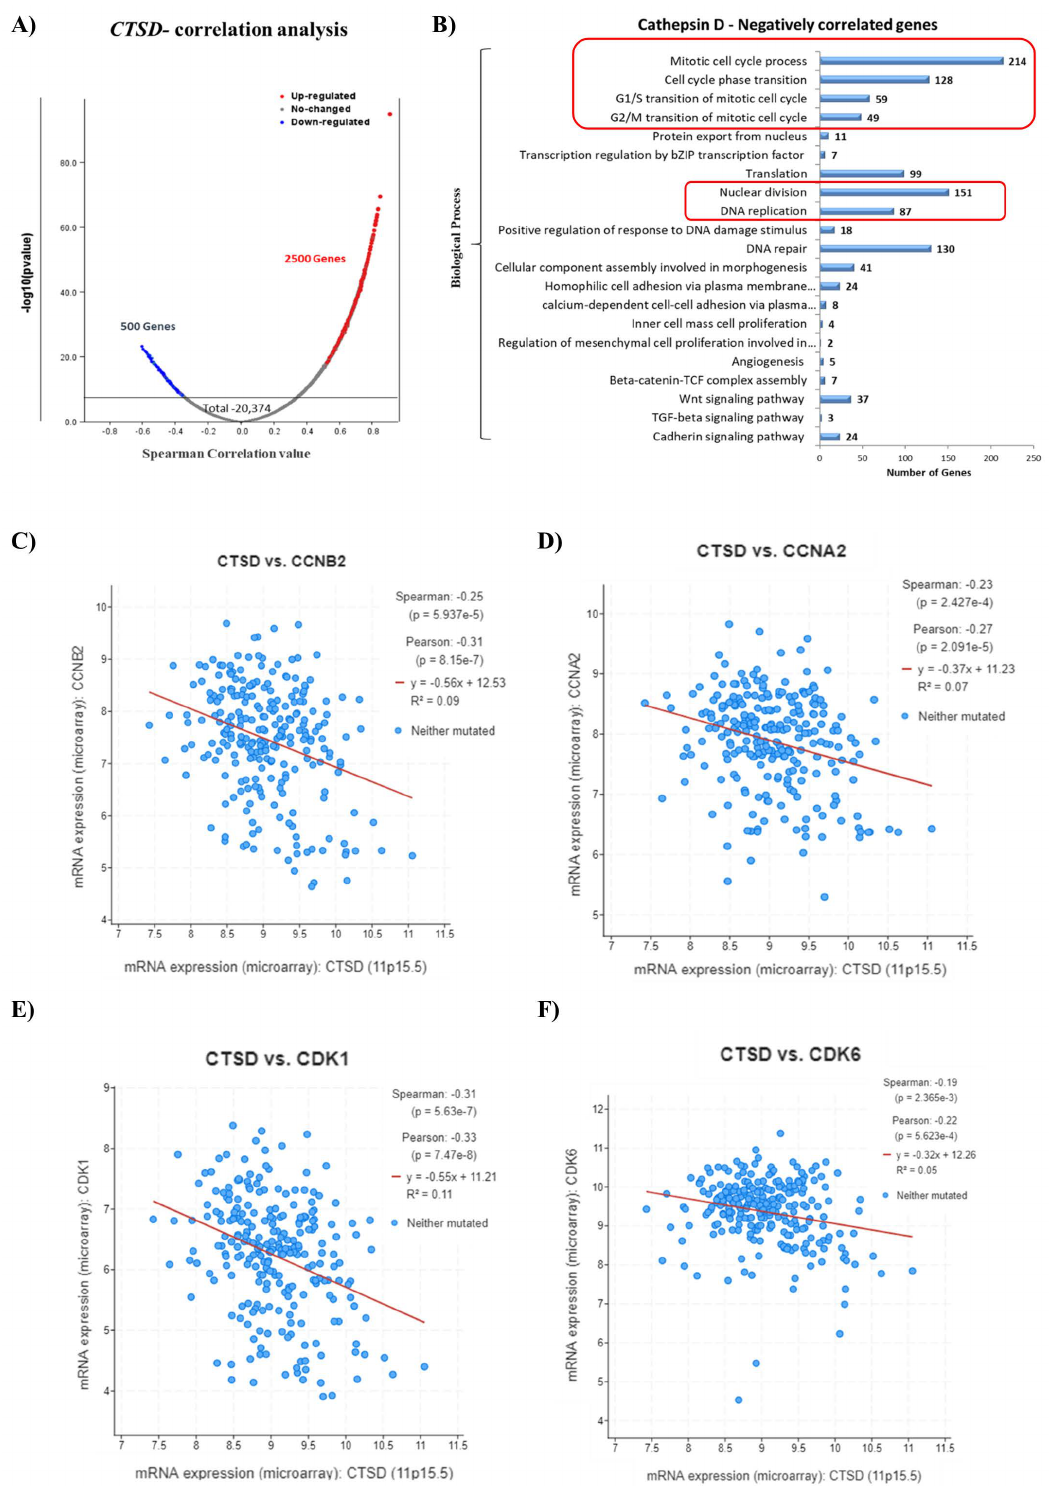
Figure 3. High CTSD expression inversely correlates with genes involved in cell cycle progression. ( A ) Volcano plot displaying the differential expressed genes (DEGs). Red dots represent CTSD - positively correlated genes, while blue dots represent CTSD -negatively correlated genes. ( B ) Graph reporting the negatively correlated biological processes with CTSD . ( C – F ) Scatter plots showing the negative correlation between CTSD and CCNB2 , CCNA2 , CDK1 , CDK6 ,